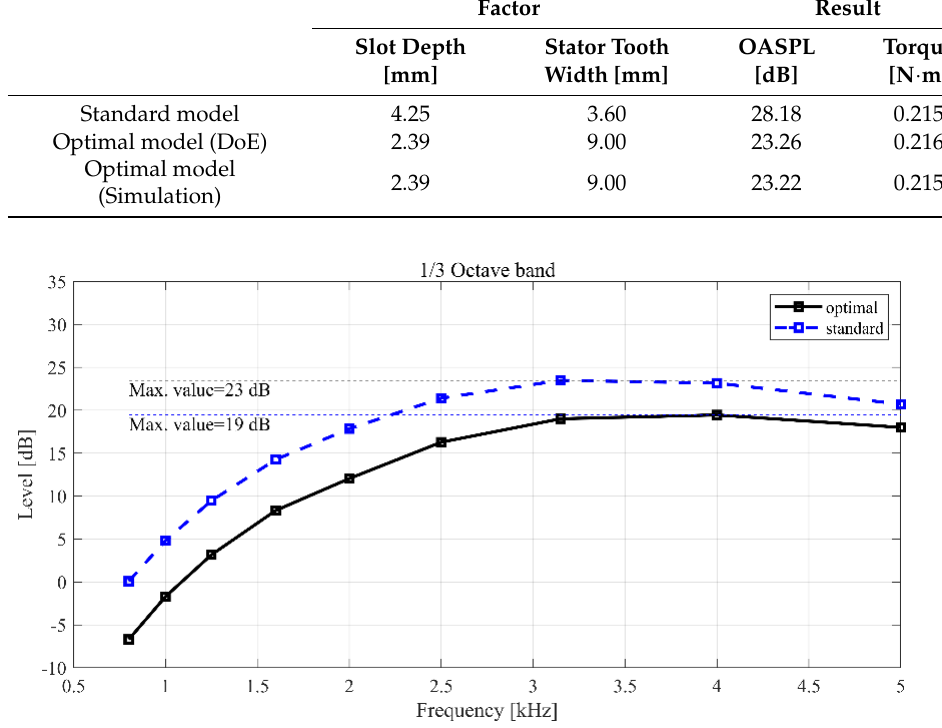
Figure 14. Comparison of the standard and optimal models of SPL.